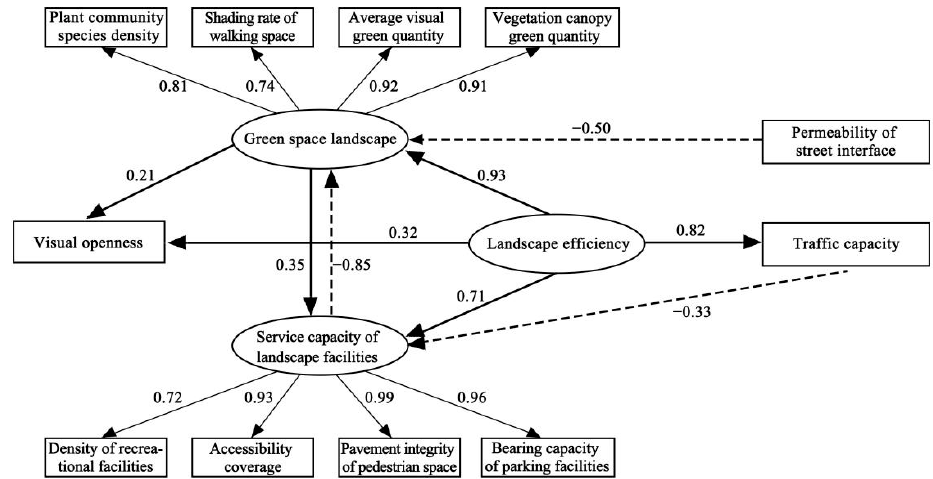
Figure 9. Fitting results of subway station entrance landscape efficiency Model (obtained by AMOS).